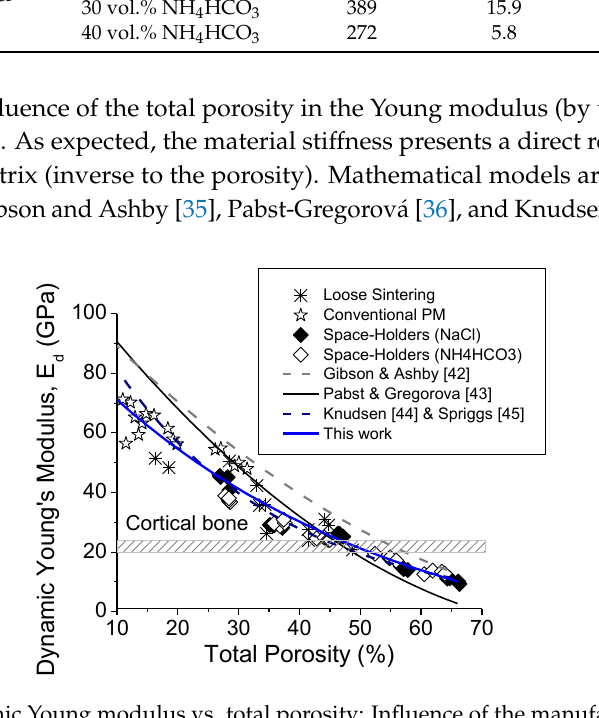
( b ) Figure 3. ( a ) Density vs. Relative Strength; ( b ) Interconnected Porosity and Relative Porosity vs. Relative Strength (porous material strength/full dense material strength). The analysis of mechanical behaviour of specimens produced via conventional PM, could be estimated using the simple brick model; however, the geometrical model is not capable of predicting any tendency. Therefore, in Equation (2), an exponential model is proposed in order to fit successfully the type and range of pores, which are produced by the space -holder technique: 𝜎 𝑦 𝜎 𝑇𝑖 = (1.88 𝑒 −3𝑃 ) − 0.2.